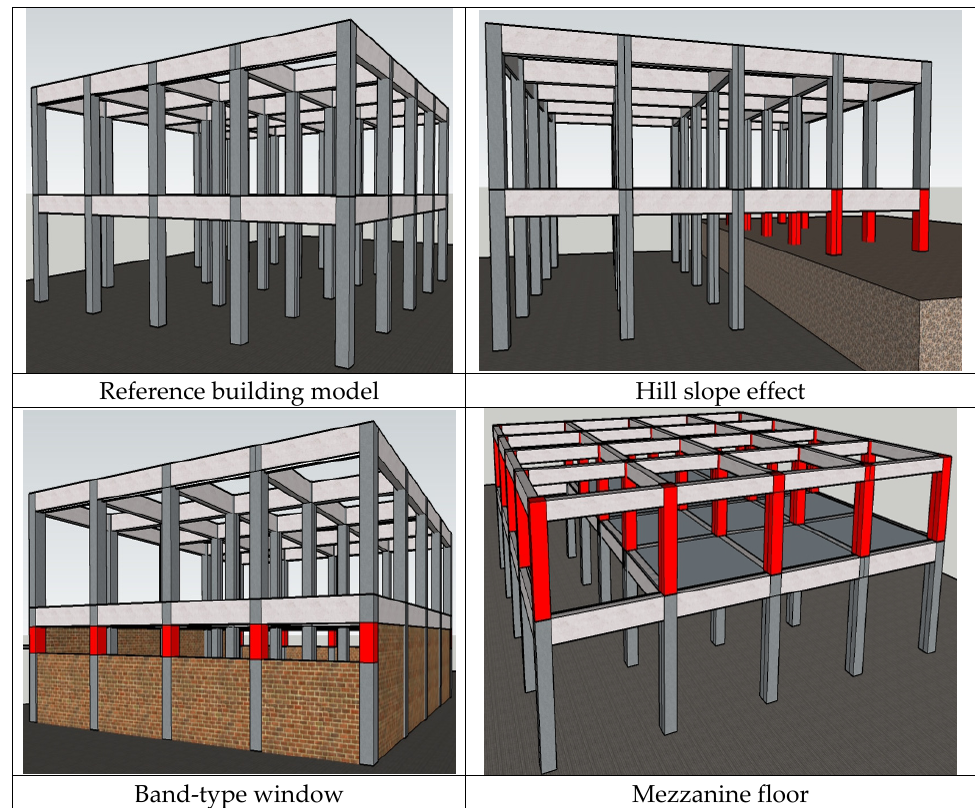
Figure 7. Four different structural models considered in the study.